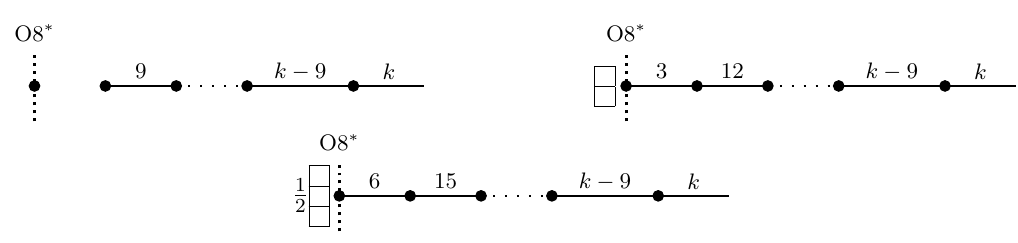
Figure 2. Type IIA configurations with O8 ∗ engineering the E 0 theory with n 0 = 9 and k = [3 n 3 0 ] . Top left: n 3 0 = 0 mod 3 . Top right: n 3 0 = 1 mod 3 . Bottom: n 3 0 = 2 mod 3